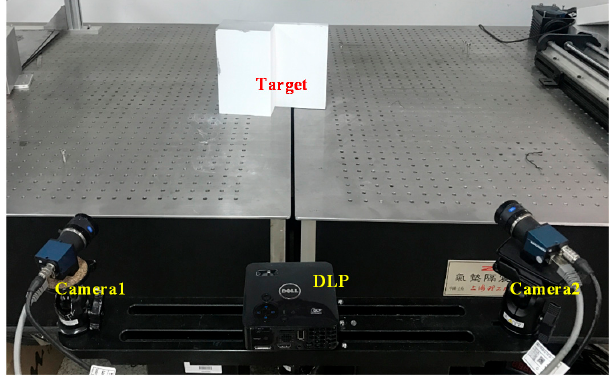
Figure 11. Stereo vision sensor and target.